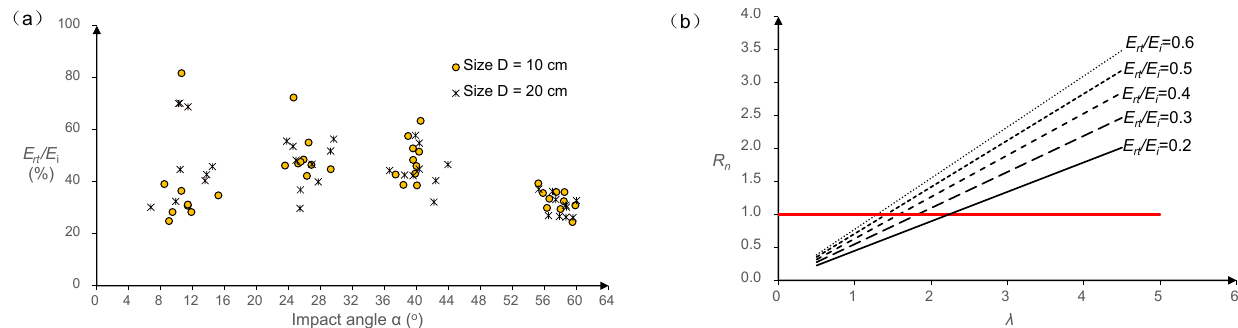
Figure 13. (a) The variation of the ratio E rt /E i with the impact angle and (b) the correlation between the normal coefficient of restitution R n and the angle coefficient λ under different E rt /E i levels.